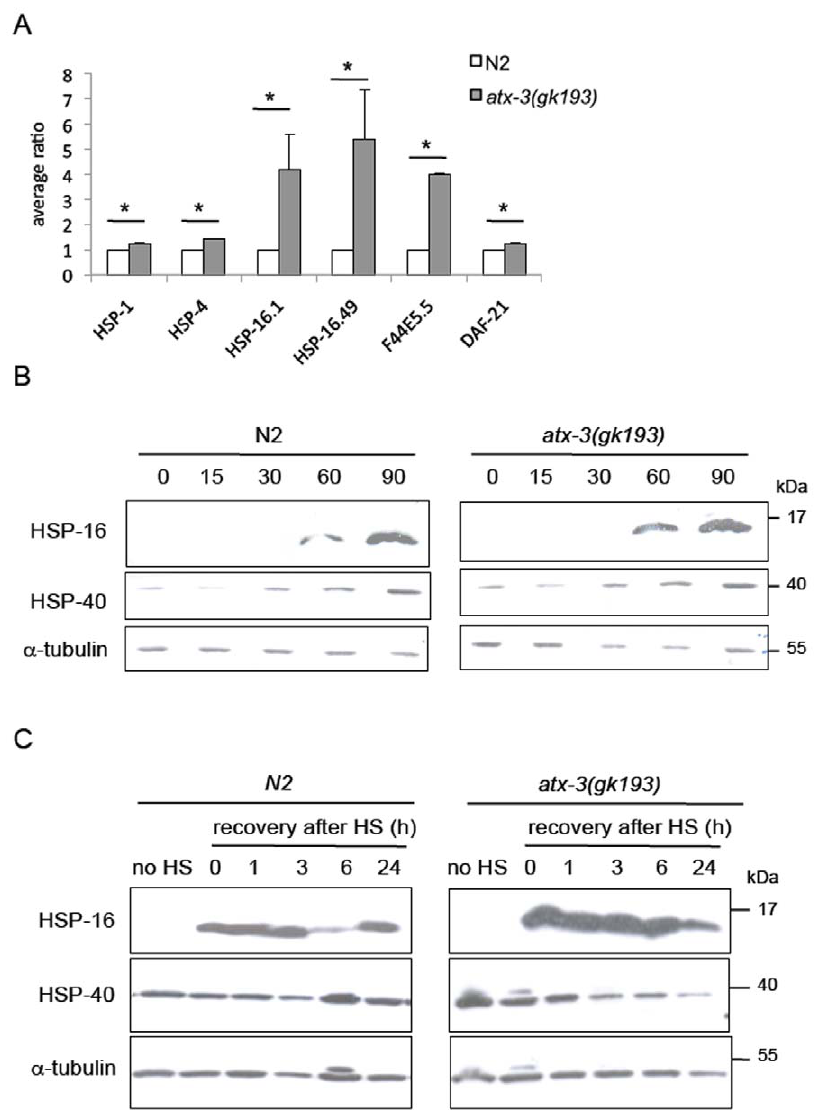
Figure 3. Absence of atx-3 leads to up-regulation of several molecular chaperones during heat shock and in the recovery at a protein level. ( A ) Summary of the proteomic results regarding the expression levels of several chaperones after heat shock of 2 h and recovery of 30 minutes at 20 u C. Shown is the average of the relative expression of chaperones normalizing wild type levels to 1. Error bars correspond to standard deviation. ( B ) Western blot analysis of constitutive (HSP-4) and inducible chaperones (HSP-16 family) in wild type and atx-3 animals during the timecourse of a heat shock. HSP-40 is expressed at all timepoints while the HPS-16 family of proteins is only detected at 60 minutes after the beginning of the heat shock. Mutants have higher levels of HSP-16 from 60–90 minutes after the beginning of the stimulus. ( C ) Atx-3 mutants have the HSP-16 family up-regulated during the timecourse of the recovery. Only 24 h after heat shock, the HSP-16 levels become similar to wild type. * p ,